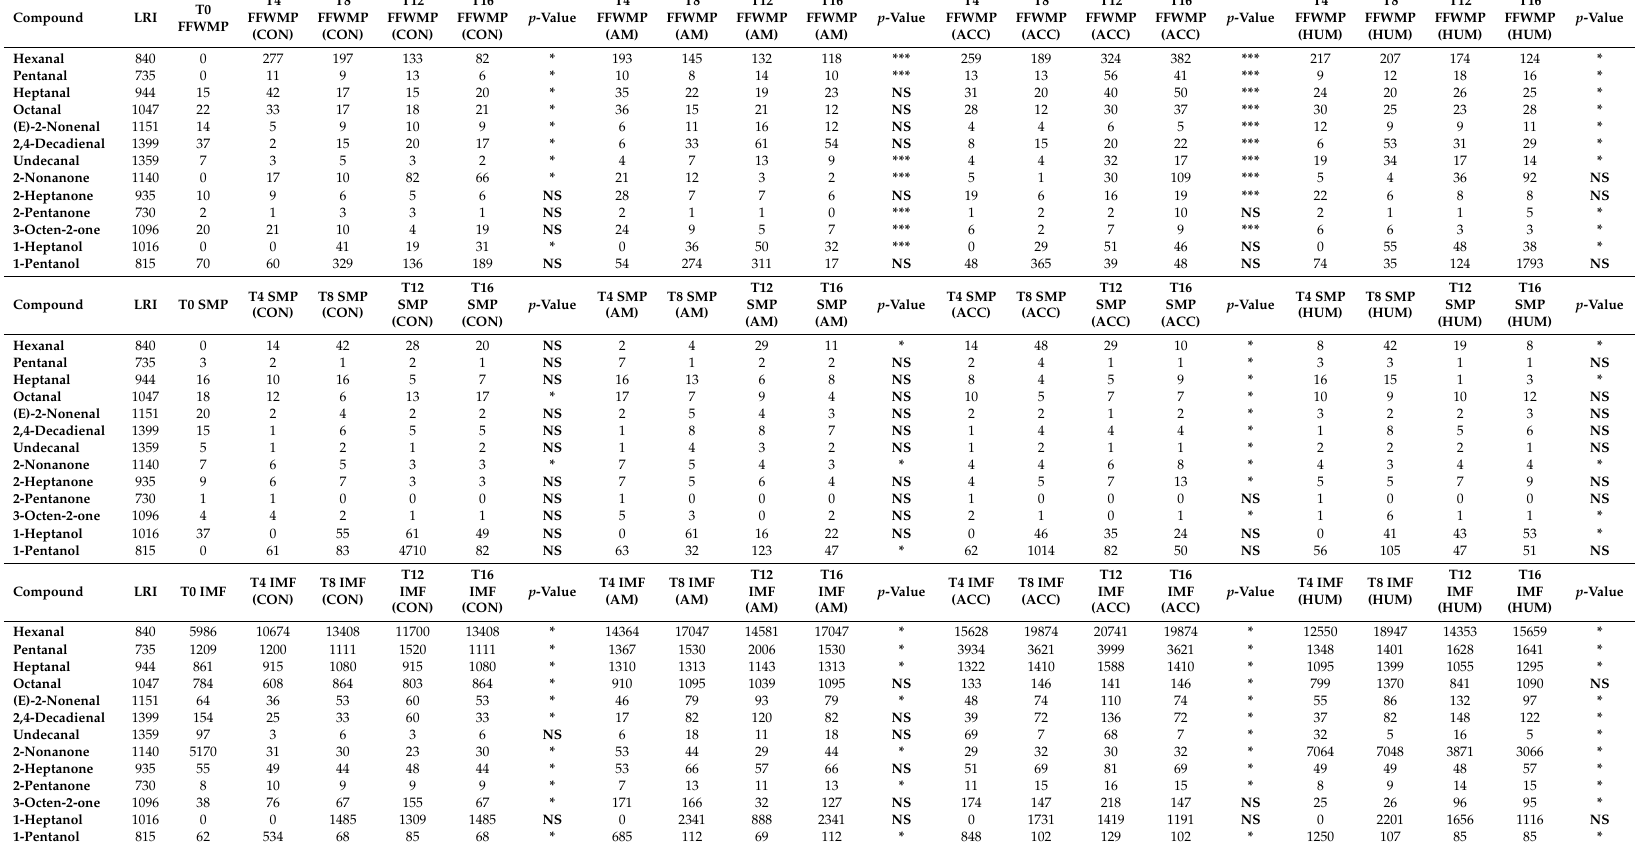
Table 3. Concentrations (mg / kg of powder; n = 3) of the 13 volatile compounds in the fat-filled whole milk powder (FFWMP), skim milk powder (SMP), and infant milk formula (IMF) samples at each time point (T0, T4, T8, T12, and T16). CON: control, − 18 ◦ C; AM: ambient, 21 ◦ C; ACC: accelerated, 37 ◦ C; HUM: humidity, 25 ◦ C and 50% humidity. * p = 0.05, *** p =